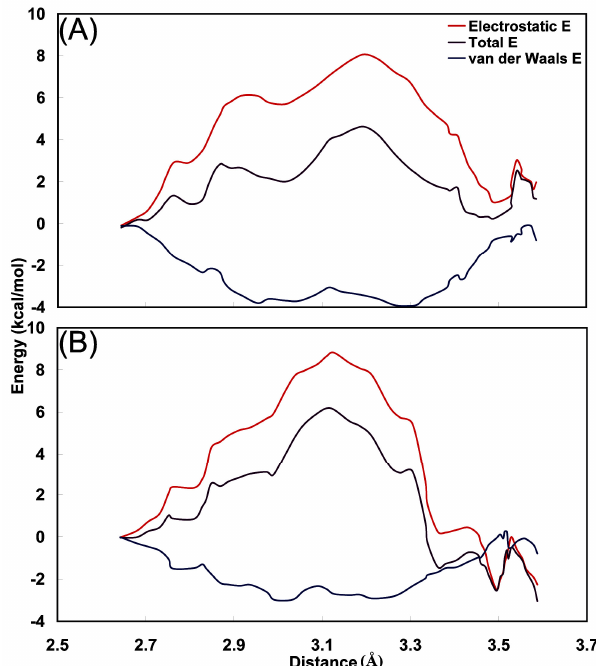
Figure 8. Change in the average energy of interaction between the carbamoyl moiety and surrounding residues, in the translocation of carbamoyl from the region of Leu300 to that of Ala299 in the (A) ALR2-(2 R ,4 S )F and (B) ALR2-(2 S ,4 S )F complex. The energy curves have been shifted to 0.0 at the point close to